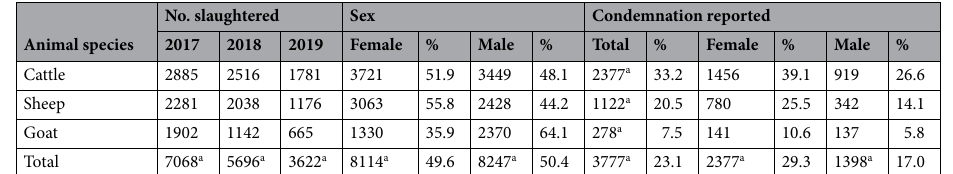
Table 1. The number of ruminants slaughtered, their sex, and the condemnation frequency, overall and stratified by sex, in two slaughterhouses in Bungoma County, western Kenya, between 17th March 2017 and 31st December 2019. a Total numbers do not add up due to missing data entries for the gender or condemnation variables.